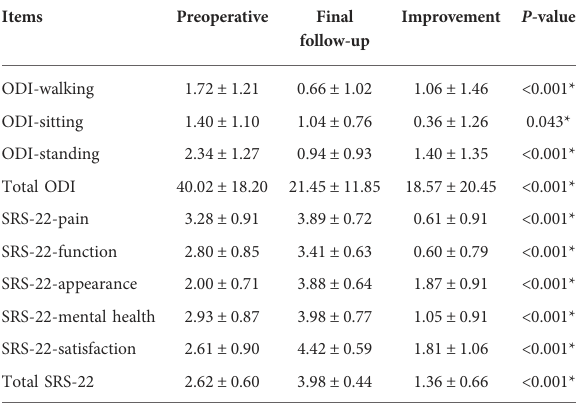
TABLE 2 Clinical outcomes of Oswestry Disability Index and Scoliosis Research Society-22 score after surgery. Items